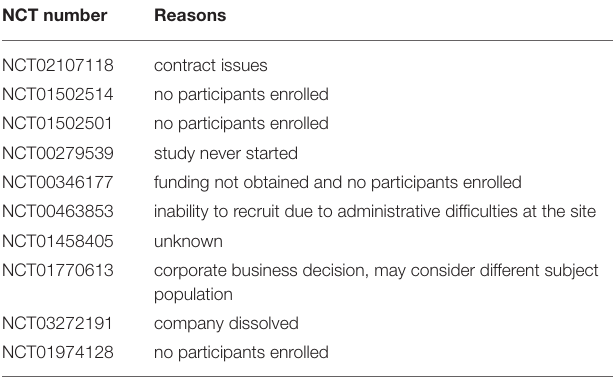
TABLE 3 | Reasons for trial withdrawn.